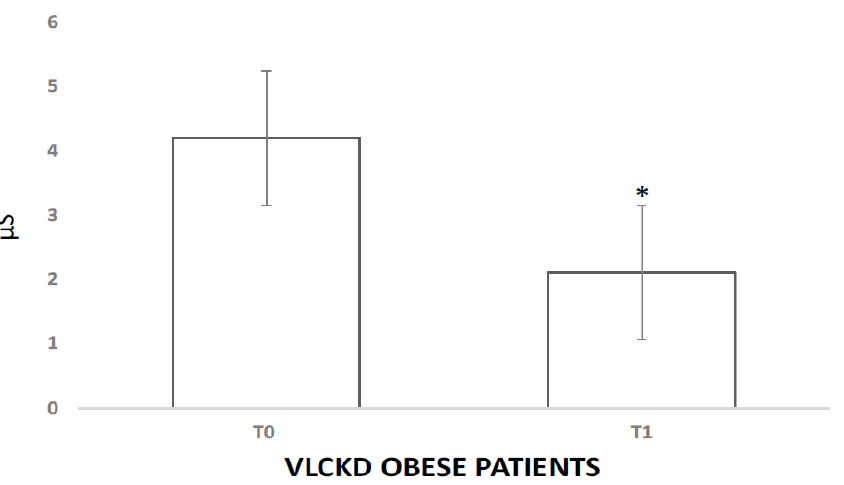
Figure 2. Changes in skin conductance level. µ S (micro-Siemens); (*) indicates a significant difference ( p < 0.05) with respect to the basal value.